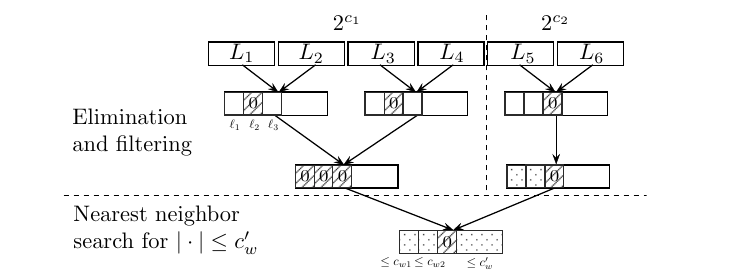
Figure 10: The Approximate k -List Algorithm, k = 6